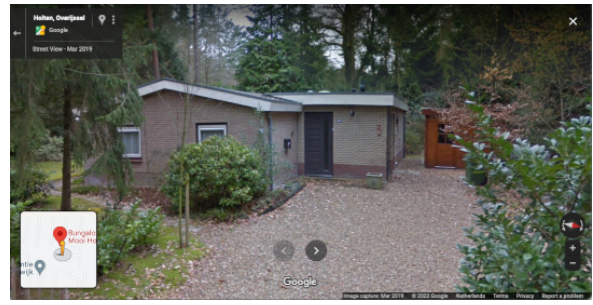
Figure 6. Example of a lodging building